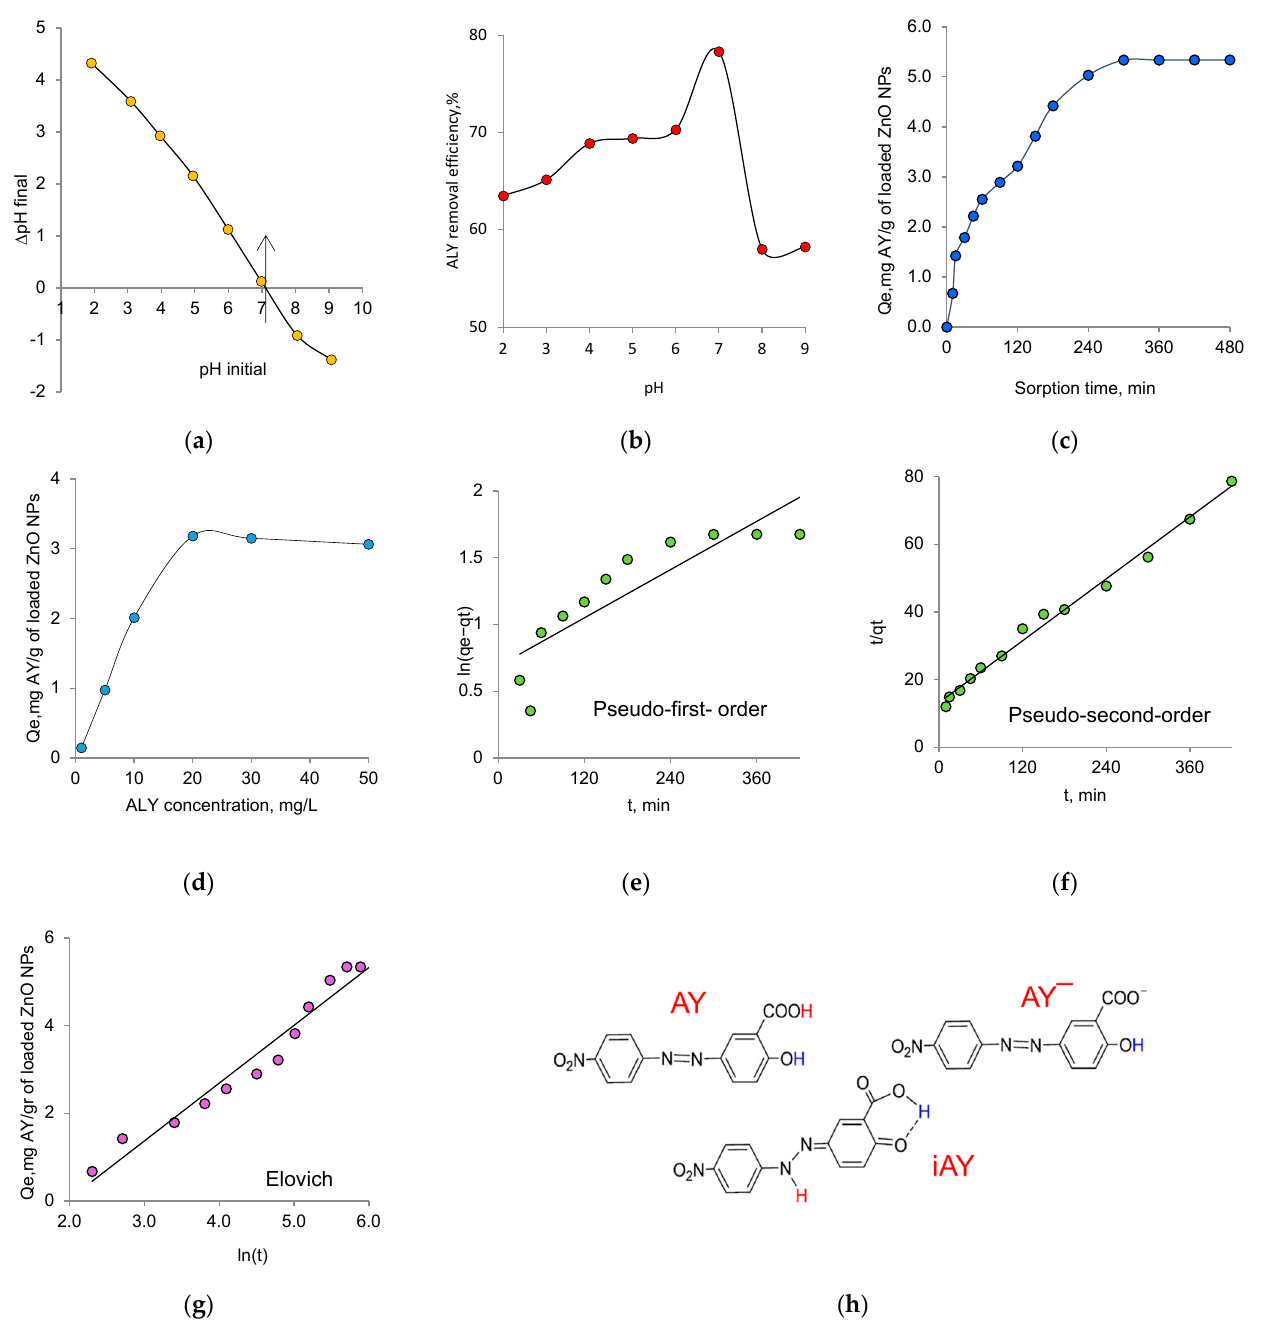
Figure 8. Point zero charge (pHPZC) plot ( a ), removal of AY as a function of solution pH ( b ) (AY concentration: 20 mg/L; biogenic ZnO NPs: 50 mg; contact time: 300 min); effect of contact time ( c ) and initial dye concentration ( d ) on the sorption of AY; kinetic model plots of pseudo-first-order ( e ), pseudo-second-order ( f ) and Elovich ( g ). (pH = 7.0, biogenic ZnO NPs: 50 mg; contact time: 120 min), ( h ) different forms of AY depending on solution pH.